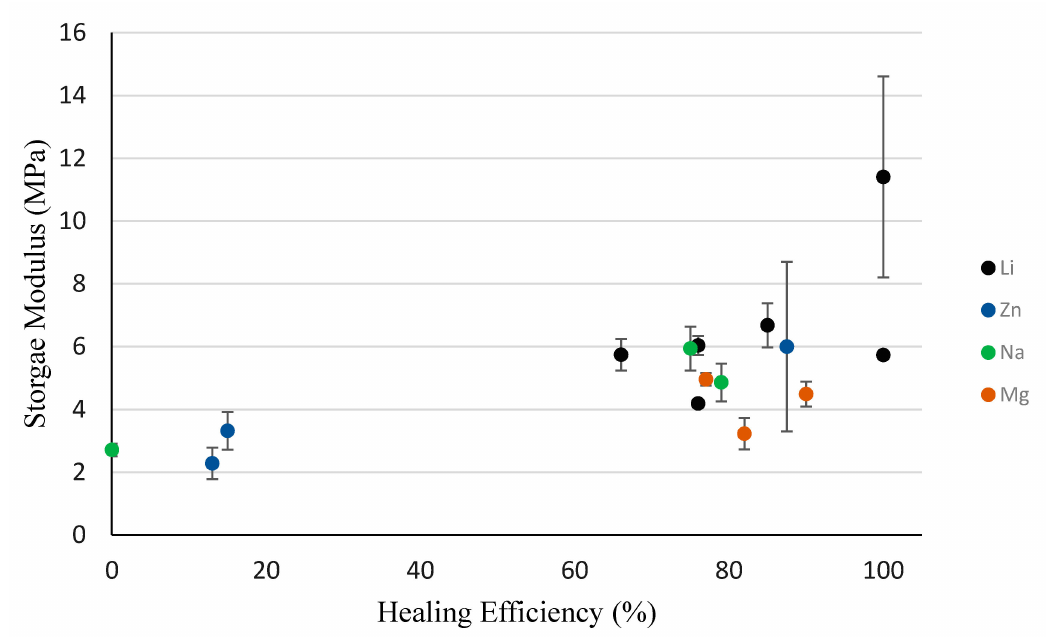
Figure 17. Storage Modulus at 94.5 ◦ C for all PEMAA polymers in relation to the healing